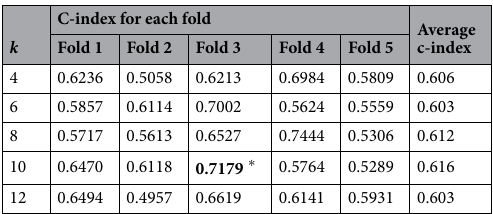
Table 2. C-index of 5-fold cross validation results for MIL deep learning architecture (Model 1). *Trained model of the best performing fold is used for univariate and multivariate experiments.